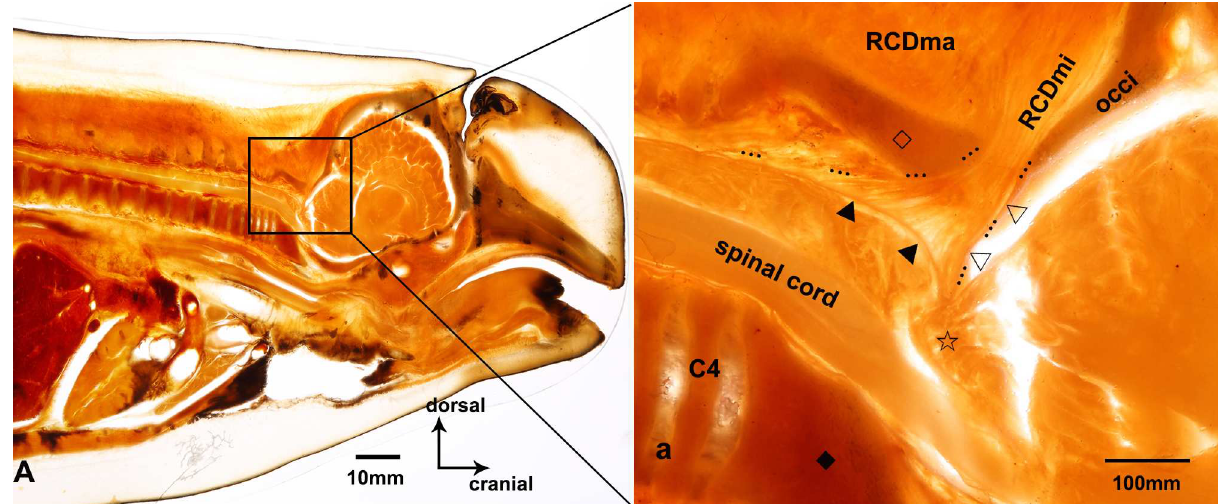
Fig 3. Sagittal sectional P45 plastinated sheet of suboccipital region of the Neophocaena phocaenoides . A: Sagittal section of P45 plastinatedsheet of the Neophocaena phocaenoides . a: The magnifiedarea of suboccipitalregion. RCDmi: the rectus capitis dorsalminor. RCDma: the rectus capitis dorsal major. C4: the fourth cervical vertebra. occi: occiput. ☆ : cerebellomedullary cistern. ▲ : spinal dura mater. 4 : cerebraldura mater. (cid:5) : the fused spinousprocess of the first three cervical vertebrae. ◆ : the fused vertebral body of the first three cervical vertebrae. ... : the